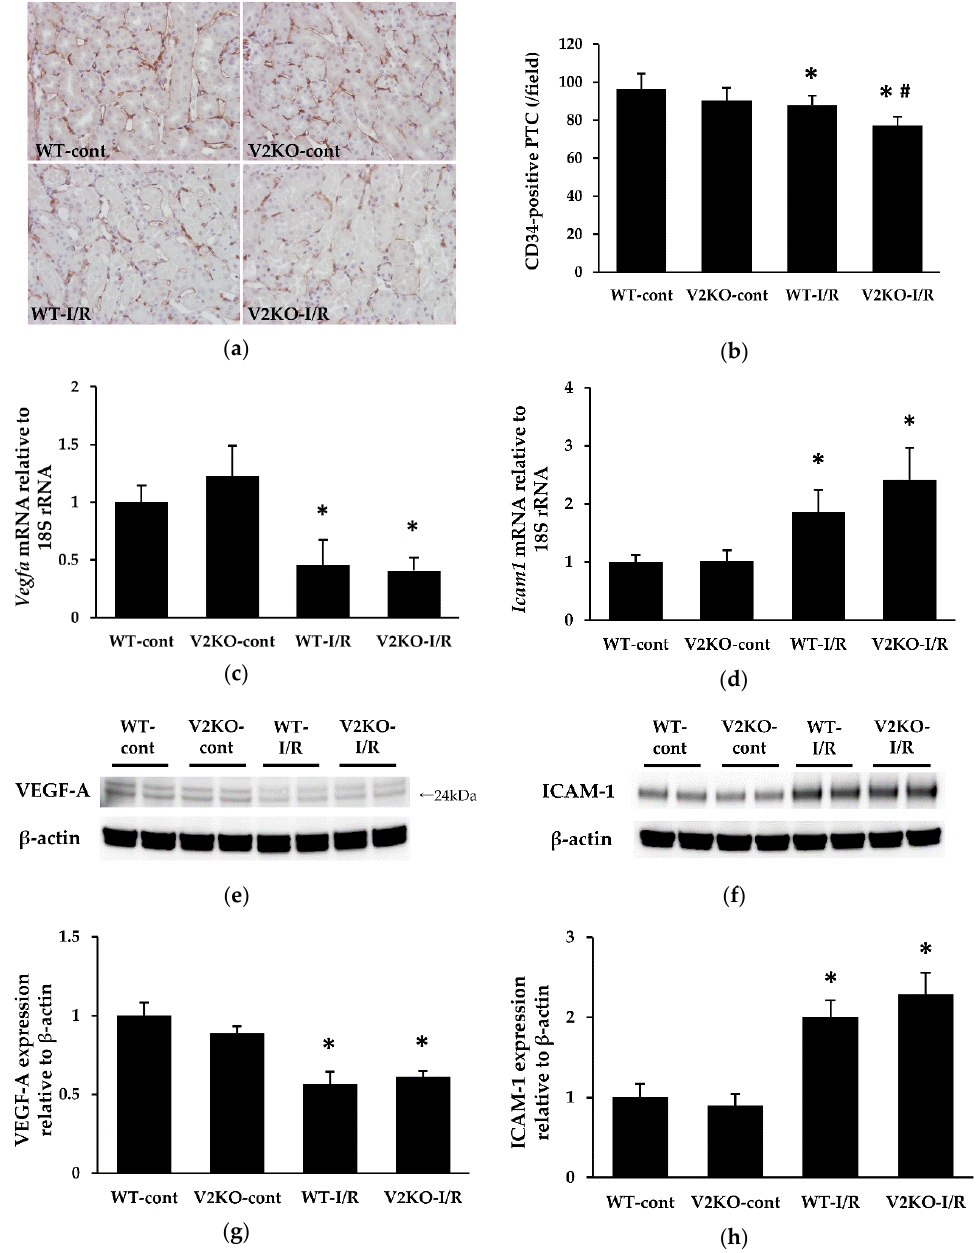
Figure 4. VASH2 deficiency accelerated I/R-induced peritubular capillary (PTC) loss in the kidney. ( a ) Immunohistochemical images of the endothelial marker CD34 in the kidney (original magnification, ×200). ( b ) The decrease in the number of CD34-positive PTCs was greater in V2KO-I/R mice than WT-I/R mice; ( c ) Vegfa and ( d ) Icam1 mRNA expression in the kidney. Data were normalized with expression of 18S rRNA. ( e , f ) Immunoblots to quantify protein levels of VEGF-A and ICAM-1, respectively. VEGF-A bands were observed at 24 kDa. Each lane was loaded with 40 µ g of protein. ( g , h ) Densitometric analysis of the immunoblots. Data were normalized to β -actin. n = 6 for each group. * p < 0.01 vs. WT-cont, # p < 0.05 vs. WT-I / R. Each column shows the mean ±